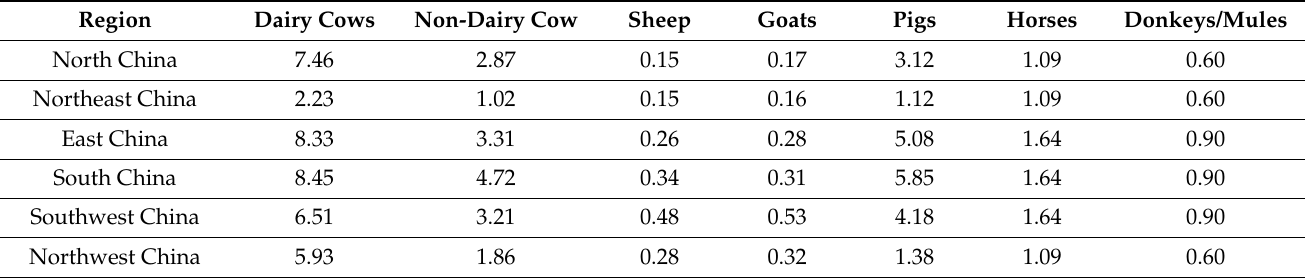
Table 2. Methane emission factors for manure management